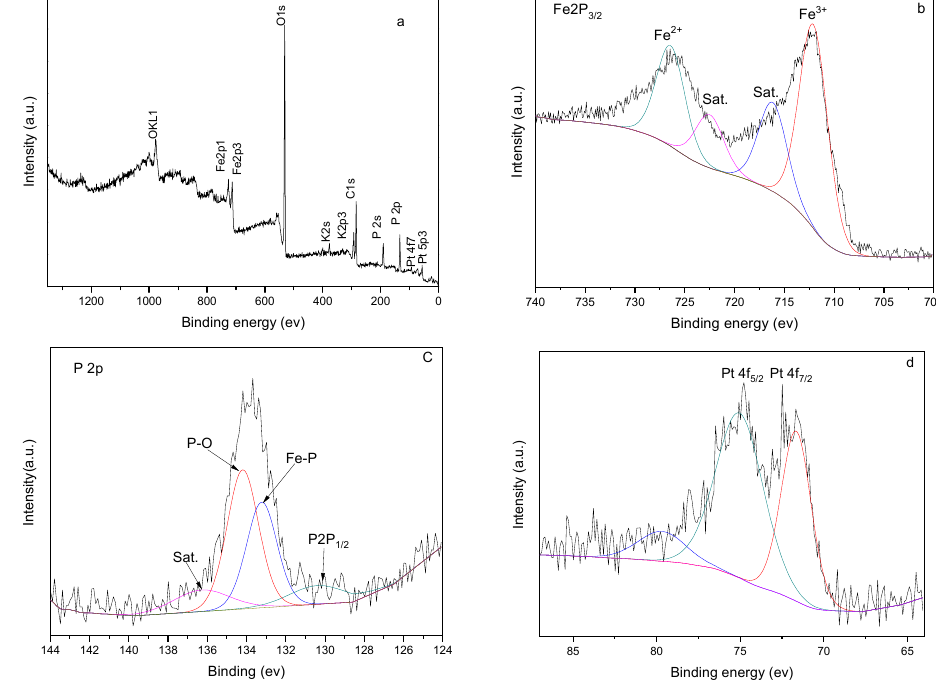
Figure 4. XPS spectra of FeP ‐ Pt/CC ( a ) survey spectrum, ( b ) Fe 2p, ( c ) P 2p and ( d ) Pt 4f.